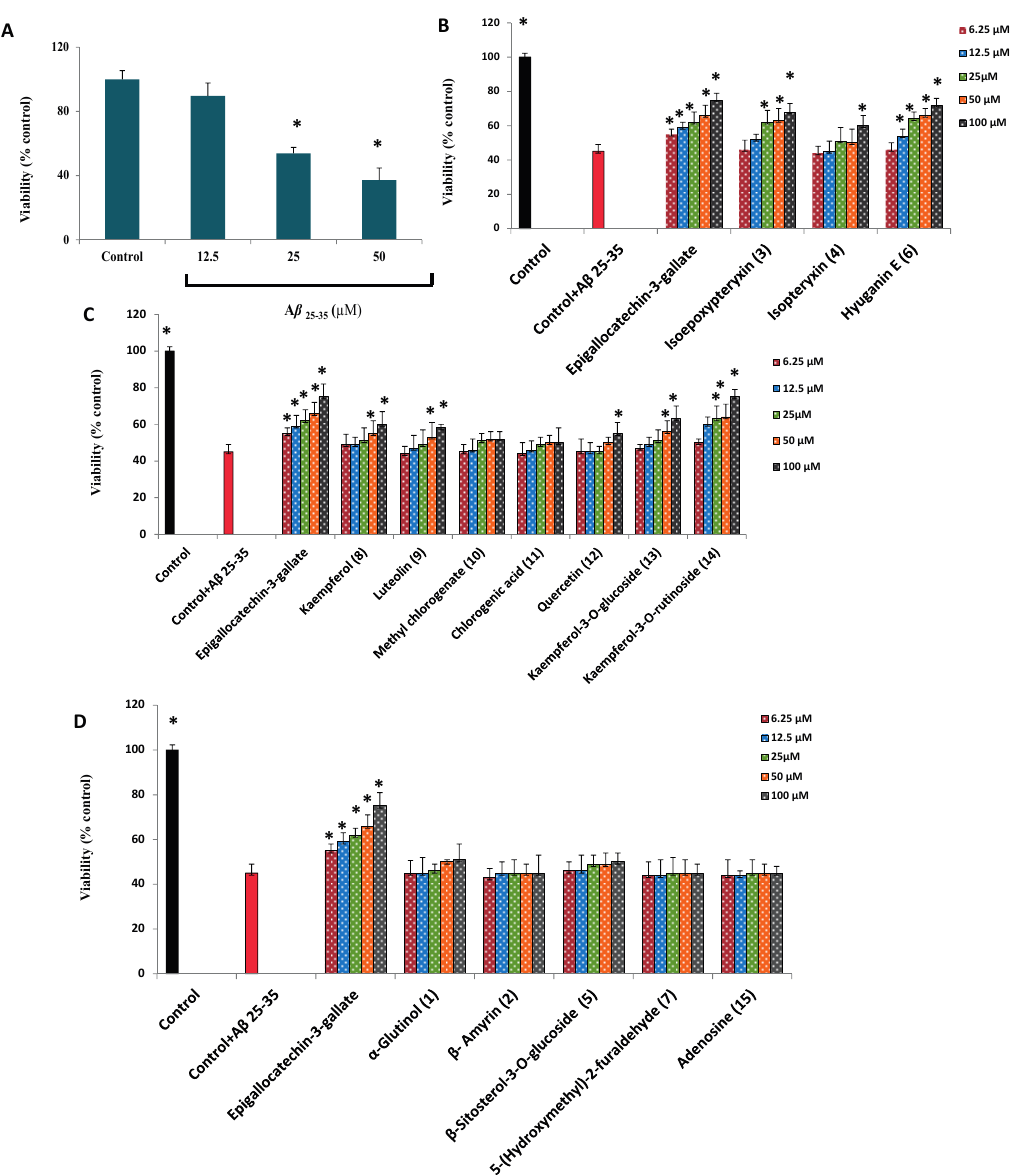
Figure 5. ( A ) dose-dependent cytotoxic effects of A β 25-35 on Neuro-2A cells. ( B – D ) neuroprotection against A β 25-35 (25 µM) induced neurotoxicity in neuro-2A cells by isolated coumarins, phenolic compounds and others, respectively. All values are means ± SDs ( n = 5). * Significant difference from control in (A) and from cell viability of of A β 25-35 (25 µM) treatment at p <